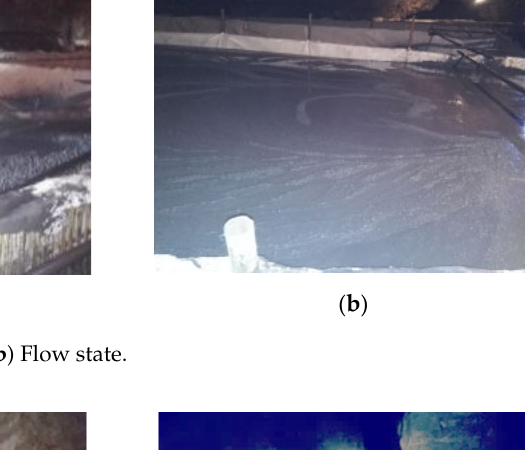
Figure 19. ( a ) Filling process; ( b ) Flow state.